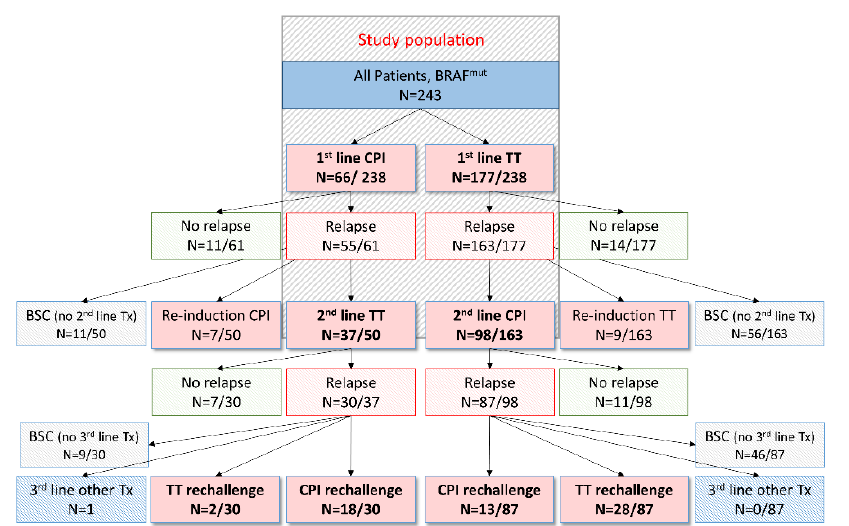
Figure 1. Flow chart showing the selection steps of the retrospective study and the treatment outcomes of melanoma patients after front-line treatment. We included all patients with stage IV melanoma who had confirmed BRAF-V600 mutation. Among the 243 patients, 66 patients received front-line (1L) CPI therapy and 177 were treated with front-line (1L) BRAF ± MEKi therapy. Following tumor progression upon 1L BRAF ± MEKi therapy, 98 patients subsequently received CPI in a second-line (2L) setting. Among these 98 patients, 87 showed tumor progression, comprising 27 rapid progressors, that did not allow for the initiation of another treatment line in 11 patients. Among the remaining 60 patients, 41 patients were again treated with CPI, BRAF ± MEKi therapy or chemotherapy. On the other hand, patients showing disease progression upon 1L CPI therapy ( n = 55), were either rechallenged with CPI ( n = 7) or received BRAF ± MEKi therapy in a 2L setting ( n = 37). Among these patients, 30 again showed tumor progression, which resulted in the initiation of 3L treatment in 21 patients. Abbreviations: BSC = best supportive care; CPI = immune-checkpoint-inhibitor therapy; TT = targeted therapy; Tx = treatment.